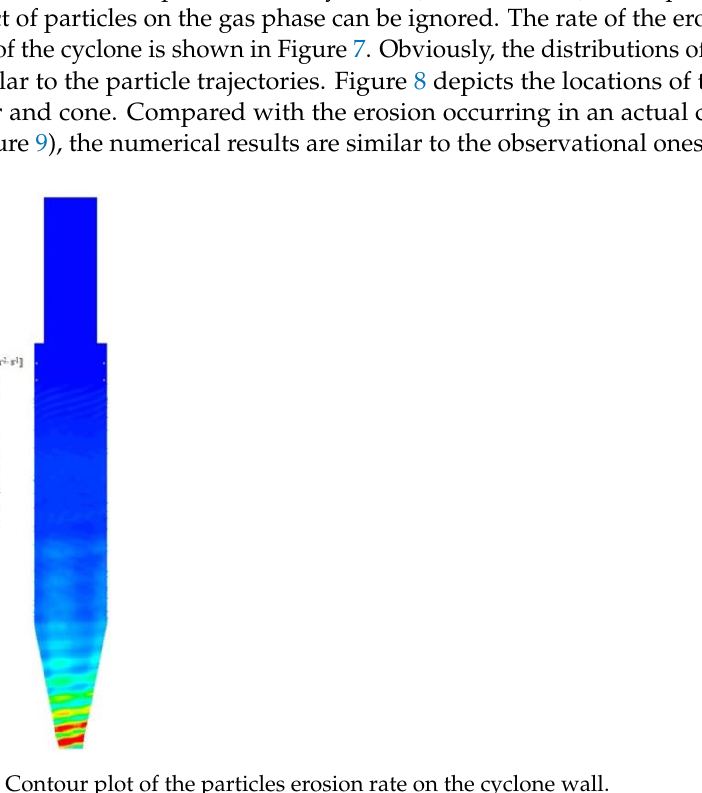
Figure 6. Tangential velocity profiles at z = − 500 mm section ( v in = 8 m/s).